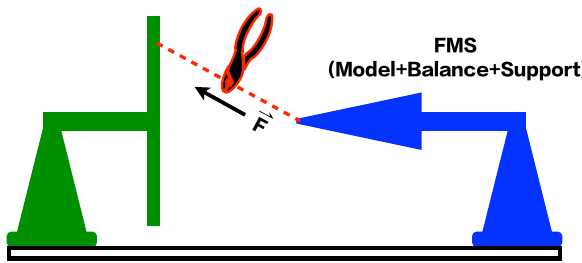
Figure 4. Schematic diagram of the step loading of SV-DSC